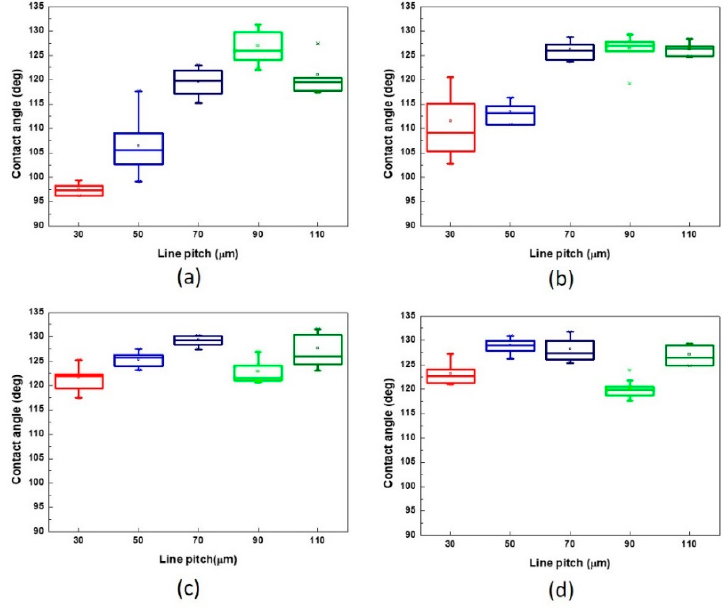
Figure 7. Contact angle of physiological saline droplet on the XO RGP contact lens with different line pitches under the scanning speed of ( a ) 500, ( b ) 1000, ( c ) 1500, and ( d ) 2000 mm/s.